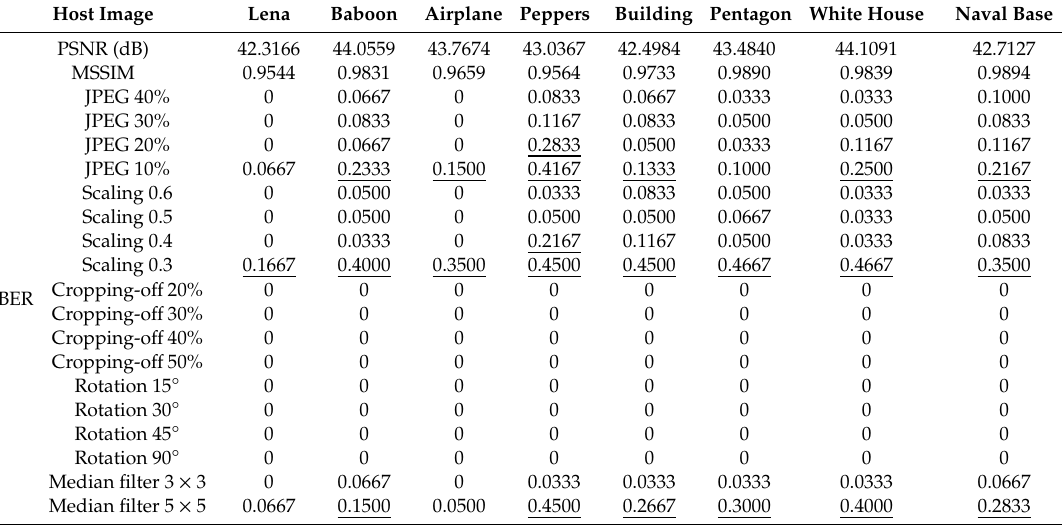
Table 2. Performance of image quality and robustness against common attacks.